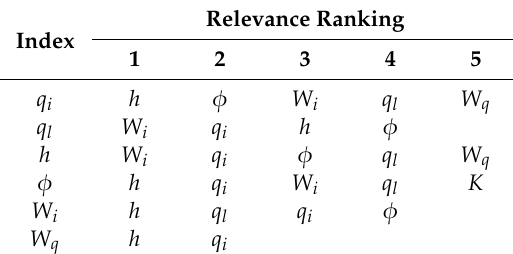
Table 3. Relevance among